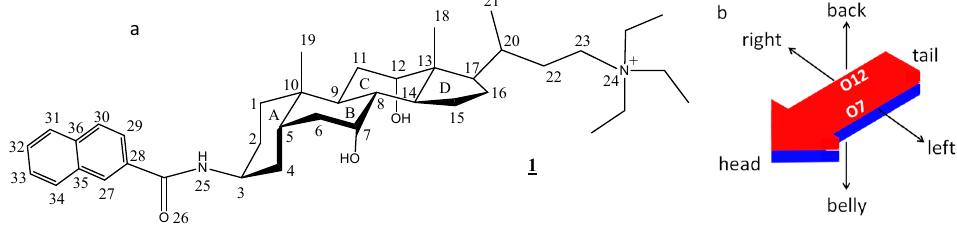
Figure 1. ( a ) The chemical structure of the compound studied in this paper ([3 β ,5 β ,7 α ,12 α ]-3-(2-naphthyloylamino)-7,12-dihydroxycholan-24-triethylammonium iodide), and the numbering of selected atoms. ( b ) Resulting scheme of the three-axial characteristics of the molecule. The red and blue colors represent, respectively, the hydrophobic and the hydrophilic faces of the molecule.